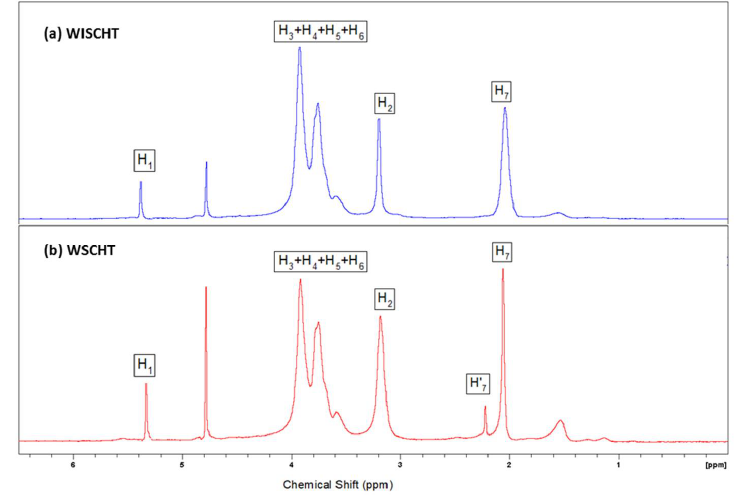
Figure 1. Proton nuclear magnetic resonance ( 1 H NMR) spectra of ( a ) W IS CHT and ( b ) W S CHT.